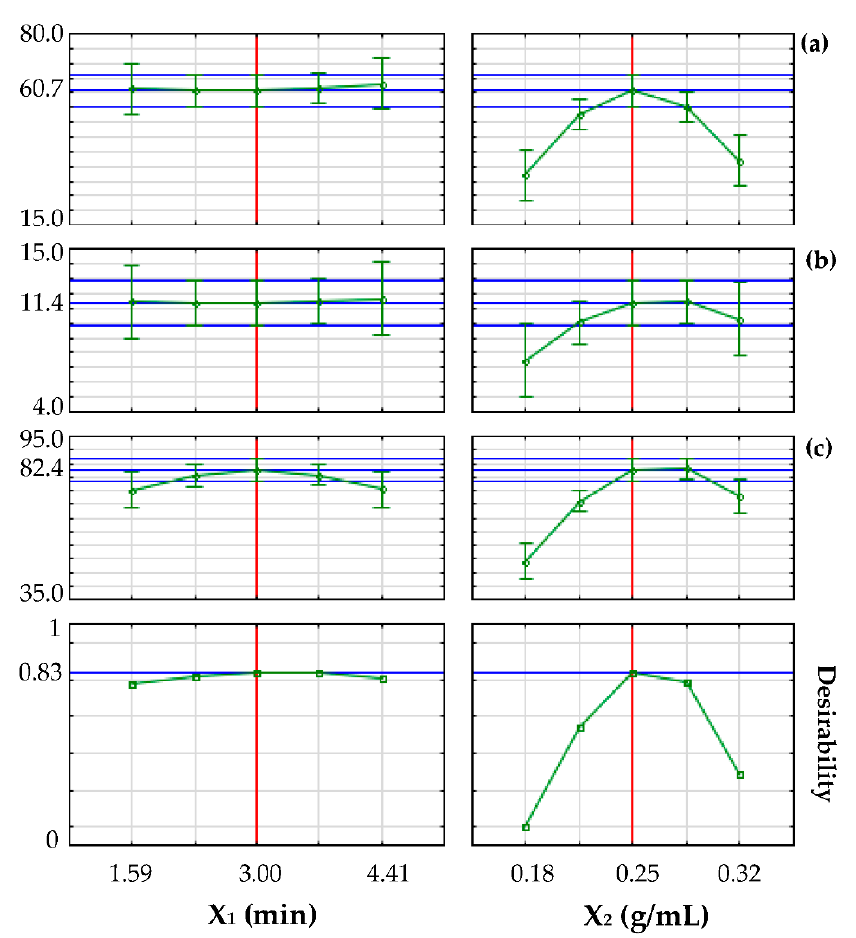
Figure 4. Desirability profiles of ( a ) cyanidin-3-O-rutinoside, ( b ) quercetin-3-O-rutinoside, and ( c ) trans -3-O-coumaroylquinic acid concentrations ( µ g/mL) in the extracts for each independent variable (X 1 and X 2 ). Blue and green lines indicate predicted and experimental value, respectively, while red lines indicate the best extraction conditions.